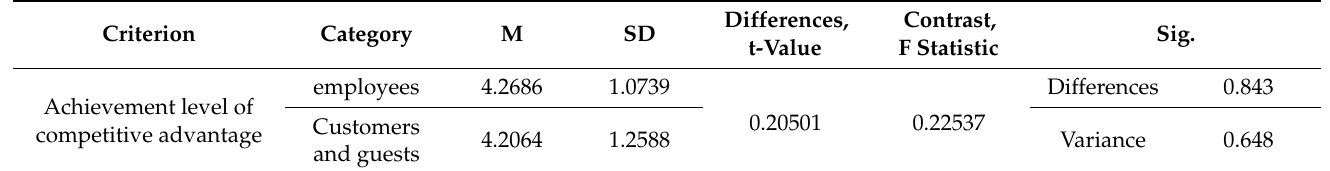
Table 4. Test of statistical differences about achieving a competitive advantage from the employees’, customers’, and guests’ perspective.